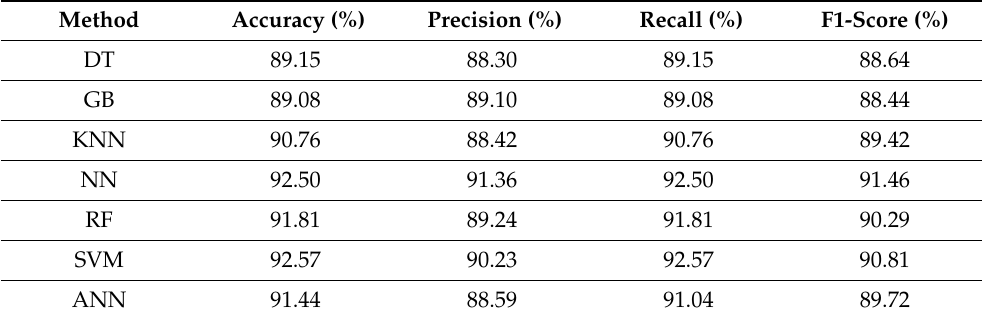
Figure 2. Decision boundary using logistic regression. Table 7. Result of machine learning using protocol split.